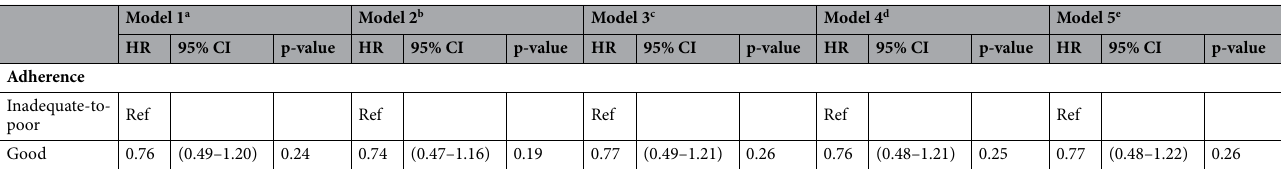
Table 5. Adherence analysis: association between adherence and occurrence of MS relapse. Ref reference, HR hazard ratio, CI confidence interval. a Model 1: crude. b Model 2: adjusted with age and sex. c Model 3: adjusted with age, sex and stepwise selection variable (use of oral contraception). d Model 4: adjusted with age, sex, number of neurologist visits, depression, anxiety, hypertension, dyslipidemia, diabetes mellitus, use of oral contraception. e Model 5: adjusted with full